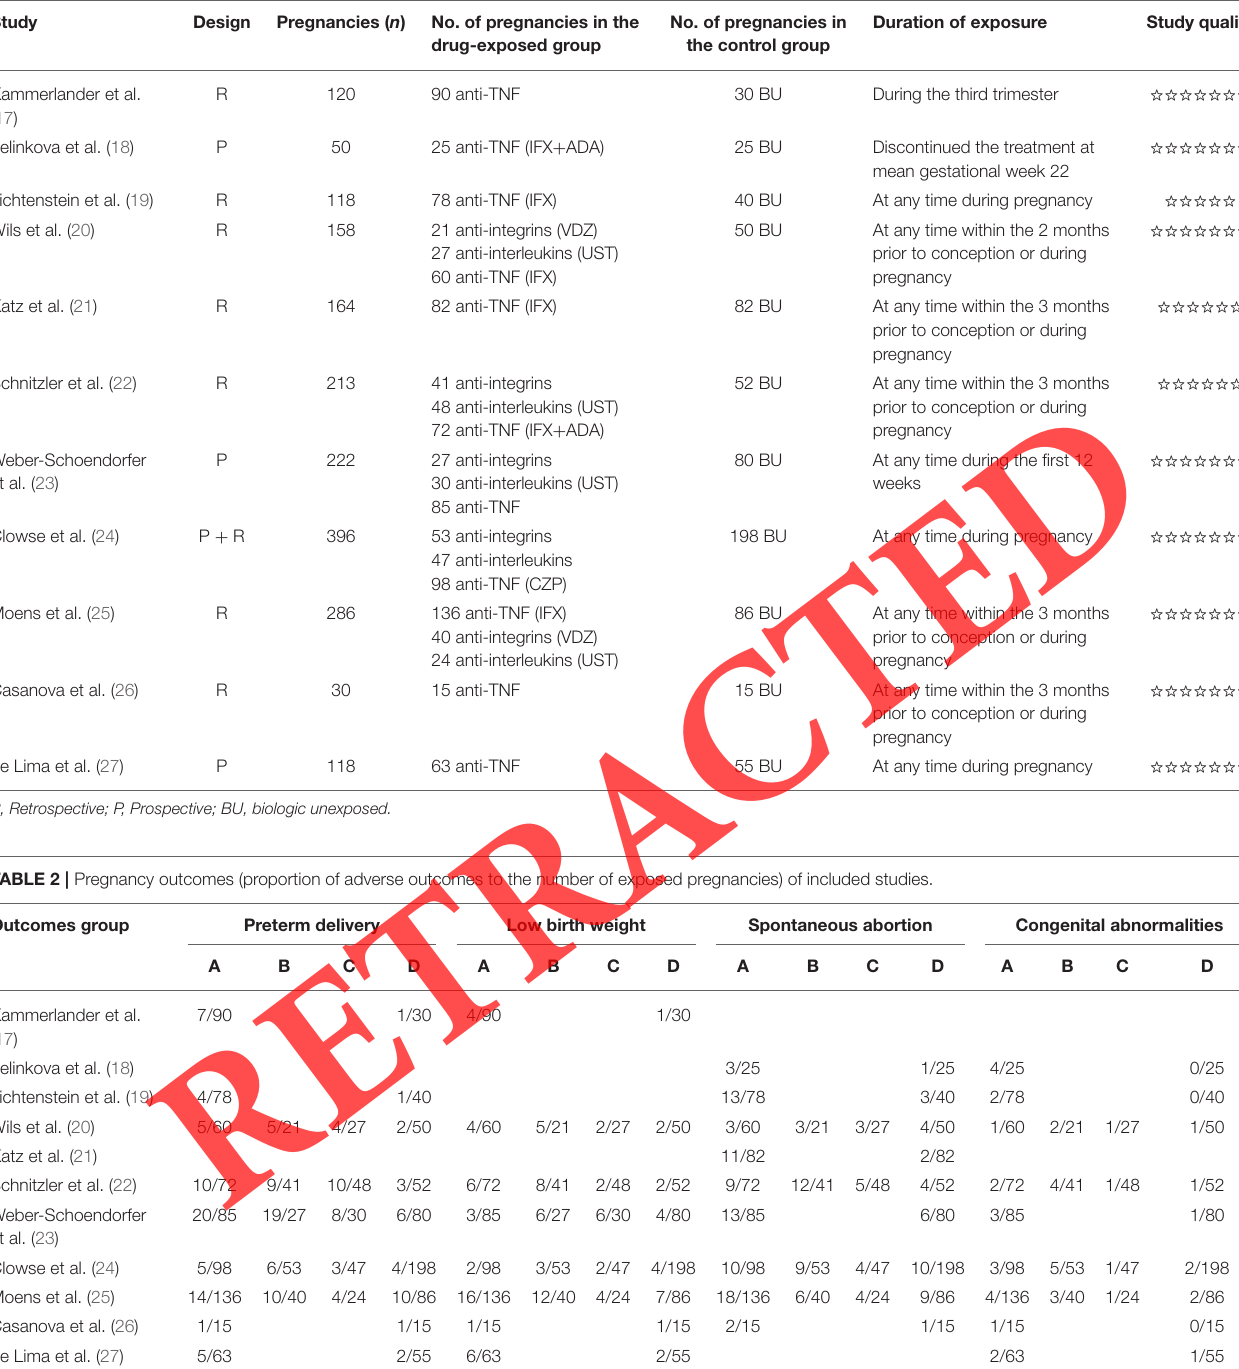
TABLE 1 | Characteristics of the studies included and the use of biologics during pregnancy.